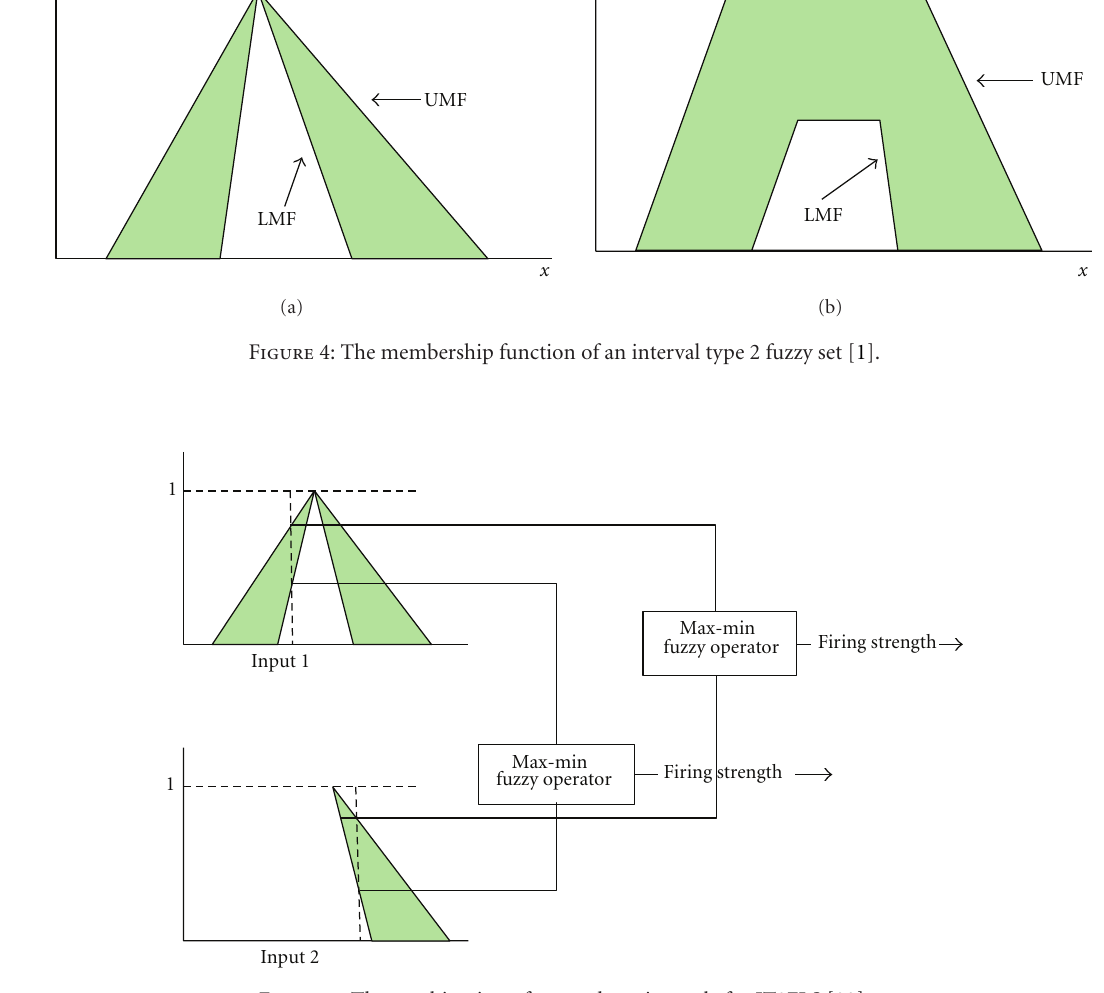
Figure 5: The combination of antecedents in a rule for IT2FLS